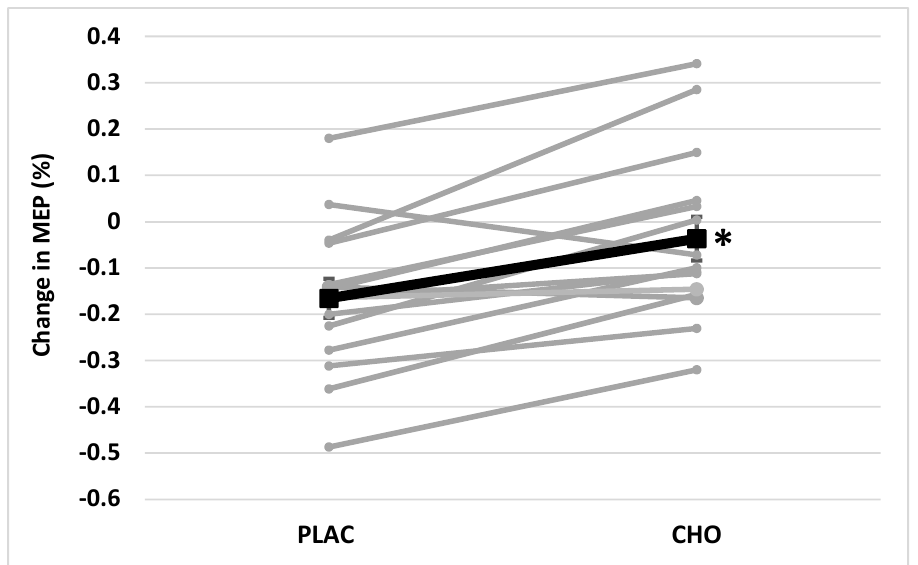
Figure 4. Relative change in motor evoked potential (MEP) after Stroop Color Word Test (SCWT) when using (PLAC) or carbohydrate (CHO) mouth rinse. * Indicated difference ( p < 0.001) from PLAC.